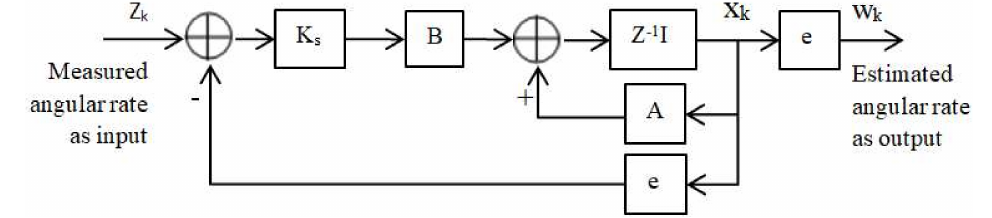
Figure 3. Estimation process of the discrete Kalman filter.